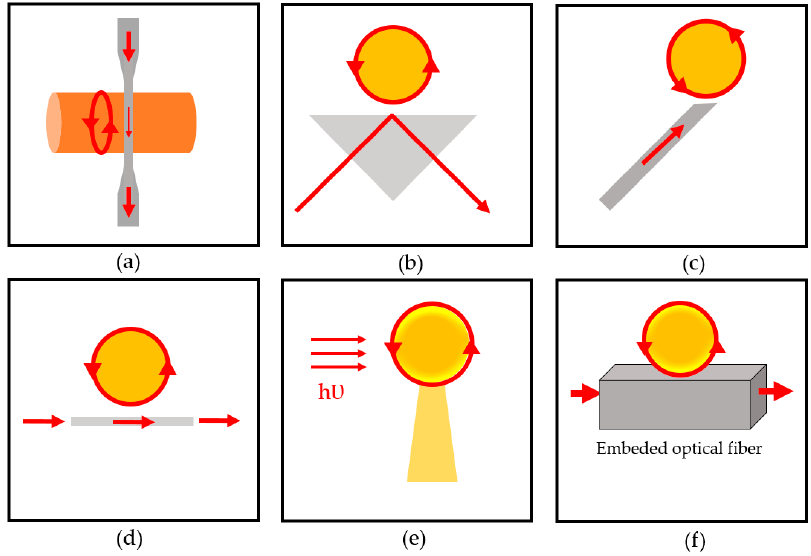
Figure 3. Various types of optical coupling. ( a ) Tapered; ( b ) prism; ( c ) angled fiber; ( d ) planar waveguide side; ( e ) free-space; ( f ) polished half-block coupler.